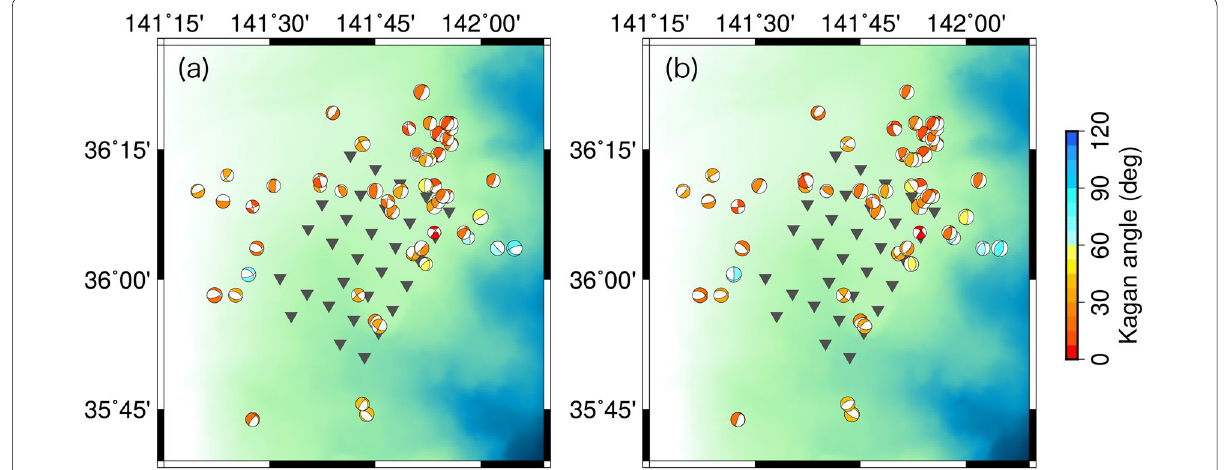
Fig. 7 Spatial distribution of Kagan angles. The colors of the moment tensors suggest the difference in Kagan angles between F-net MT and obtained CMT solutions. a Kagan angles with obtained and b with F-net MT